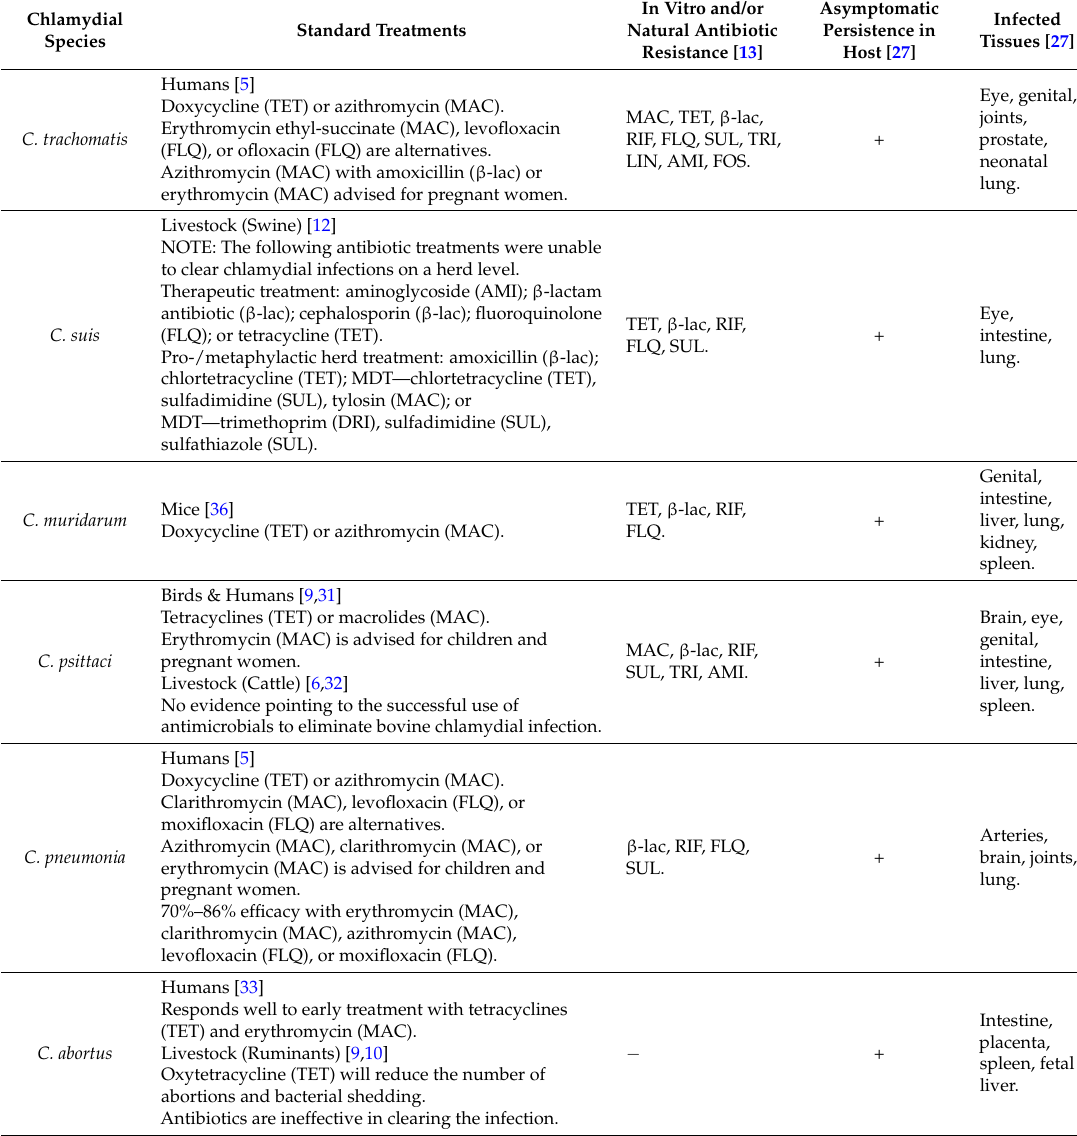
Table 1. Standard antibiotic treatments, potential resistance, and infection